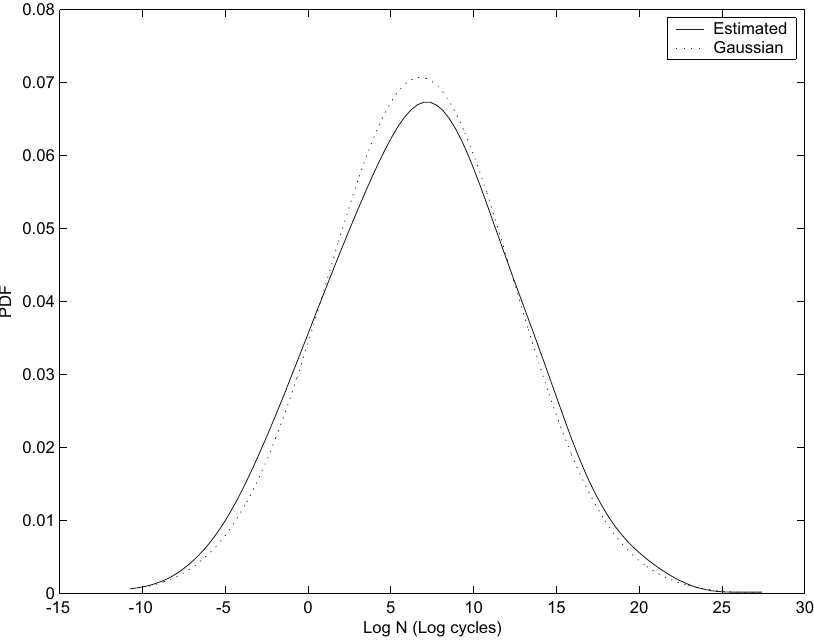
Fig. 5. Comparison of PDF of lifetimes using simulation from Eq. (2) and a fitted